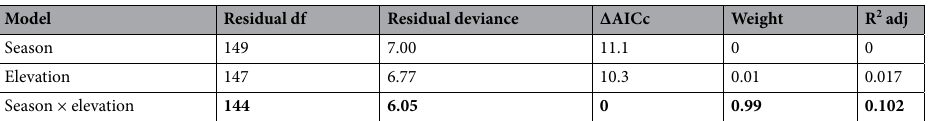
Table 2. Comparison of the effects of season, elevation, and their interaction on d’ specialisation of flower- visiting lepidopterans on Mount Cameroon. LMM with the lepidopteran families as random-effect variable were applied; models with ΔAICc ≤ 2 were considered comparable.